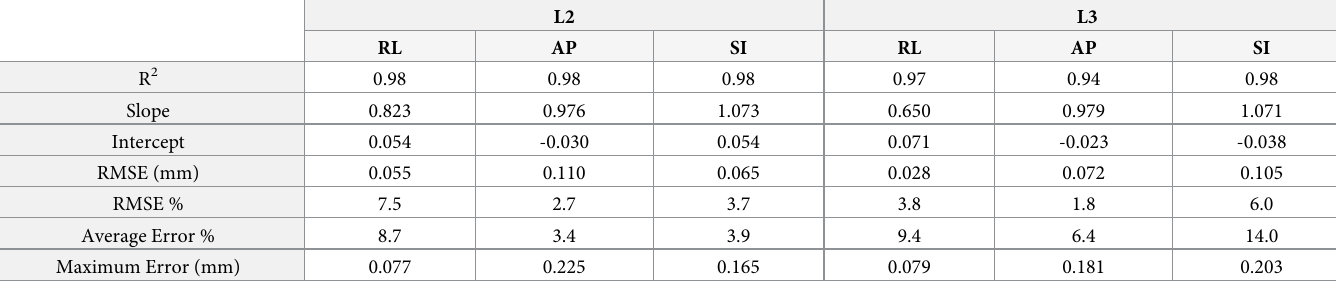
Table 1. Summary of the validation metrics values for local displacement comparisons between DIC and FE